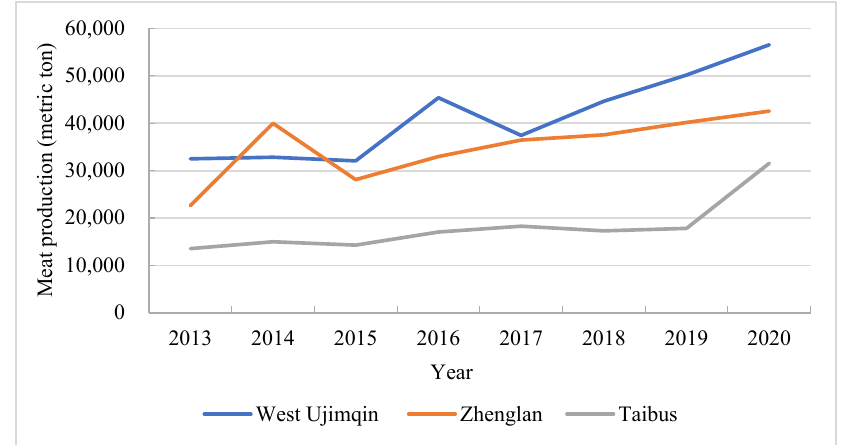
Figure A1. Gross domestic product ( a ) and per capita disposable income ( b ) of permanent resi- dents of rural and pastoral areas in three Mongolia banners.